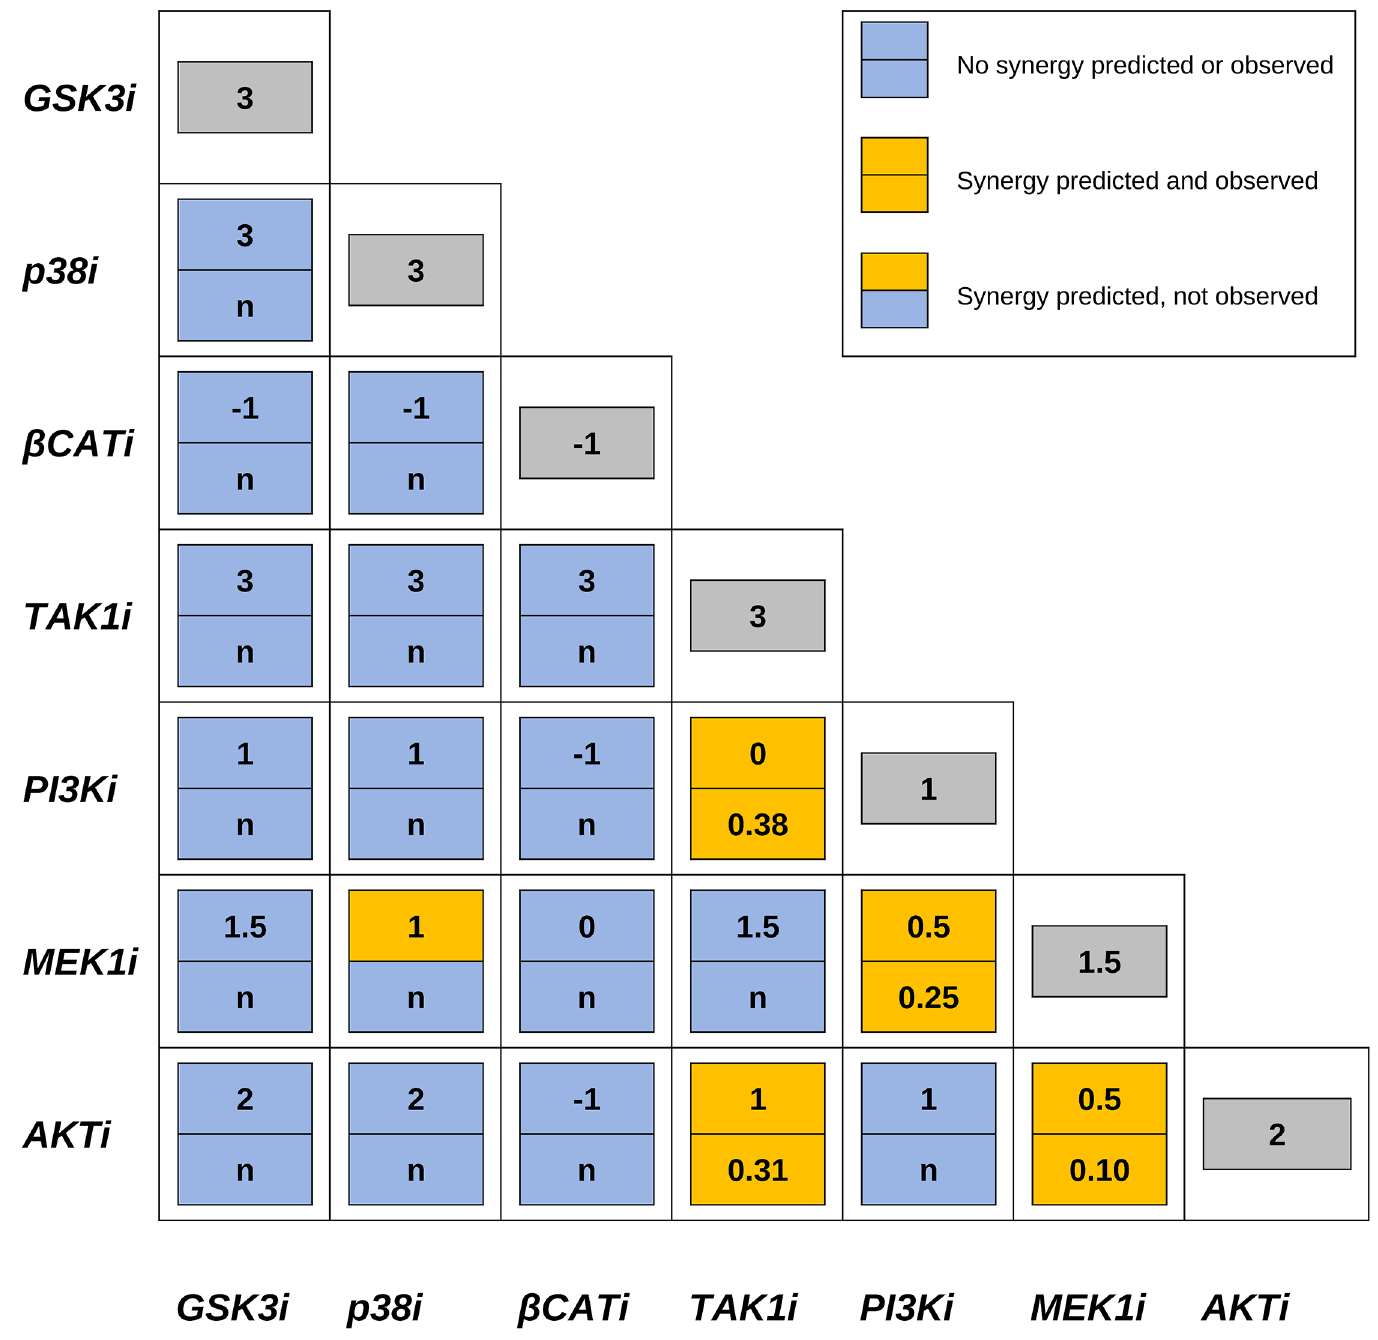
Fig 4. Effects of combined inhibitors on cell growth. Synergistic (yellow) and non-synergistic (blue) combinations are shown both as predicted by model simulations (upper panel of boxes, value of model parameter “ growth ” ) and as verified by cell growth experiments (lower panel of boxes; combinatorial indexes (synergy indicated by CI < 1) or “ n ” when non-synergy was observed).Synergy was proposed whenever the predicted growth for a combination of inhibitors was lower than the modeled effect of single drug perturbations, shown in the outer diagonal (grey, value of model parameter “ growth ”